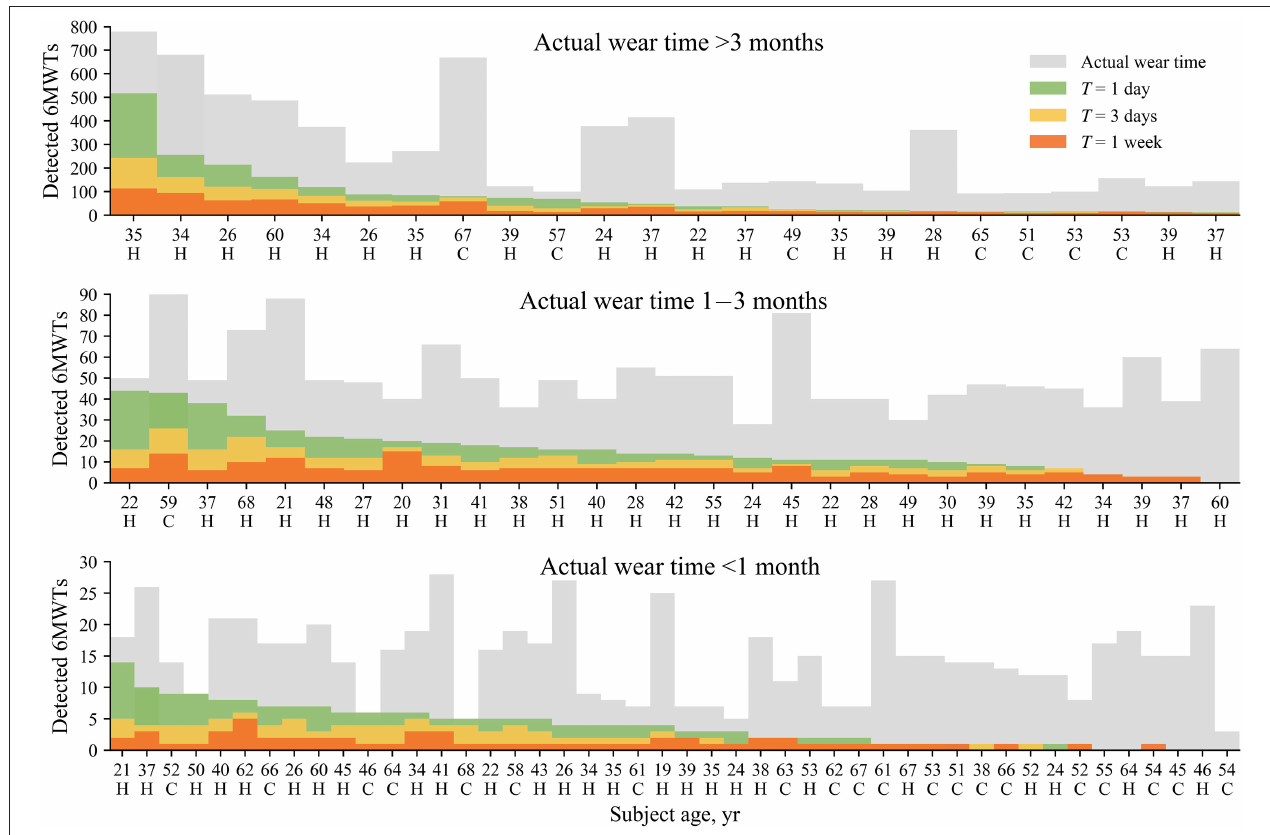
FIGURE 2 | The number of detected 6MWTs for different analysis time intervals T for each study subject. Subjects are subdivided based on the actual wear time depicted in gray. Data are sorted with respect to the number of detected 6MWTs for T = 1 day. The cadence variation σ ≤ 5 steps. In this figure, “C” denotes a patient with a CVD, whereas ‘H’–denotes a healthy